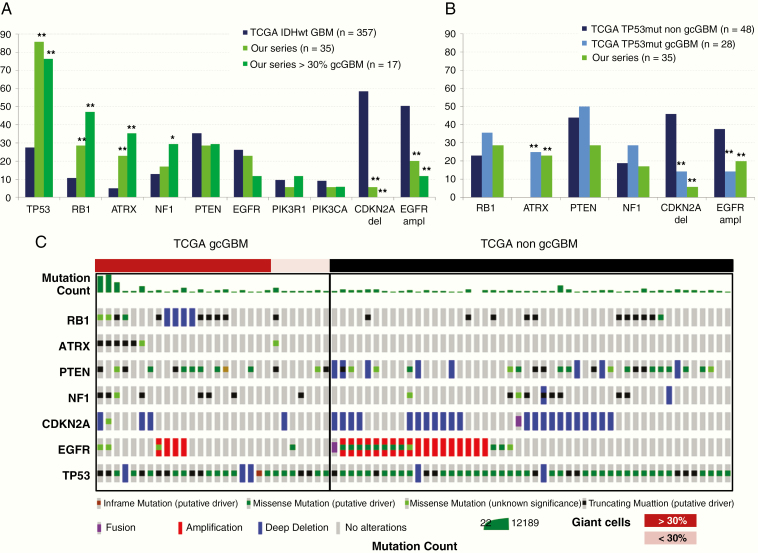
Analyses of the TCGA IDHwt GBM dataset. (A) Comparison of the gene frequency alteration between the TCGA database and our series, including that restricted to the gcGBM with more than 30% of giant cells. Note that according to the TCGA database, “Deep Deletion” indicates a deep loss, possibly a homozygous deletion. del, homozygous deletion in our data or deep deletion in TCGA database; ampl, amplification. (B) Comparison of the gene frequency alteration between TP53mut tumors without giant cells of the TCGA database (TCGA TP53mut non-gcGBBM) and those with giant cells of the TCGA database (TCGA TP53mut gcGBBM) and with our series. Fisher test, **P < .0001, *P < .05. (C) Oncoprint summary graph of 76 morphologically evaluated IDHwt, TP53mut GBM cases from the TCGA cohort. Shown are the most relevant genes and the histological review performed. Twenty-one cases showed more than 30% giant cells (dark red bar), 7 cases had less than 30% giant cells (pink), and 48 cases did not have giant cells (black).